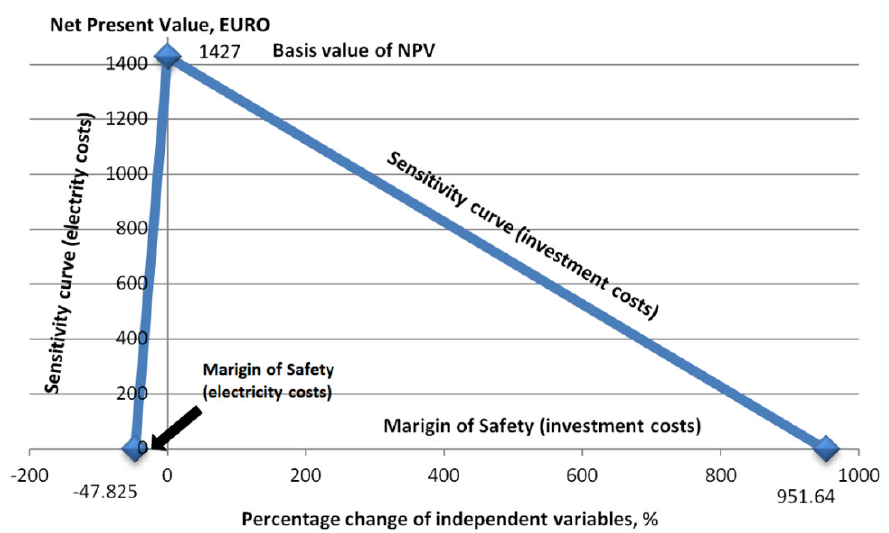
Figure 12. Graphic form of sensitivity analysis for variables that linearly change the profitability of HE_1 exchanger investments in Scenario B, Variant I and a 60-min shower time.